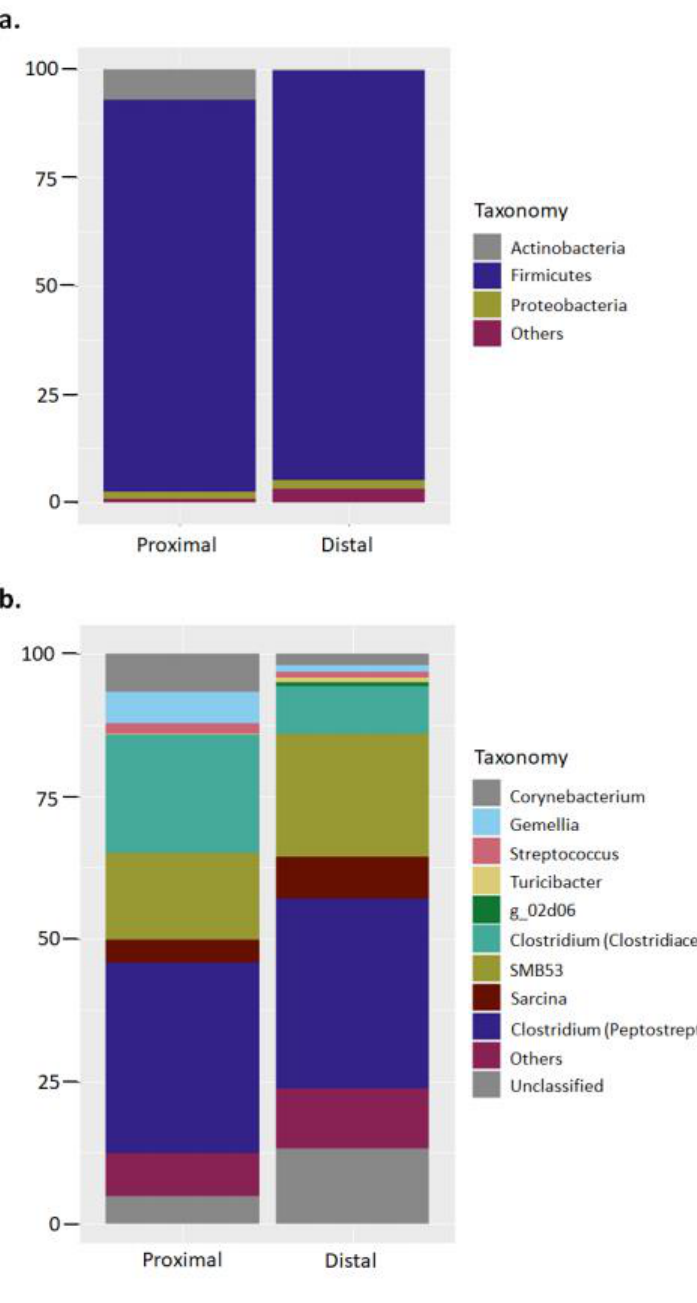
Figure 1. Major bacterial phyla and genus in the proximal and distal small intestine of captive hooded seals. The bar charts represent the relative abundance of the total 16S rRNA sequence taxonomically classified at ( a ) phylum and ( b ) genus level. Classification was performed with partial sequences of the bacterial 16S rRNA gene against the RDP-II database using RDP classifier tool.